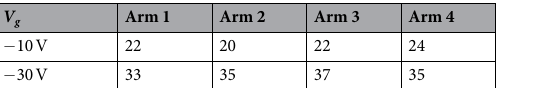
= − V and V 30 = − V, indicating symmetry of the g g